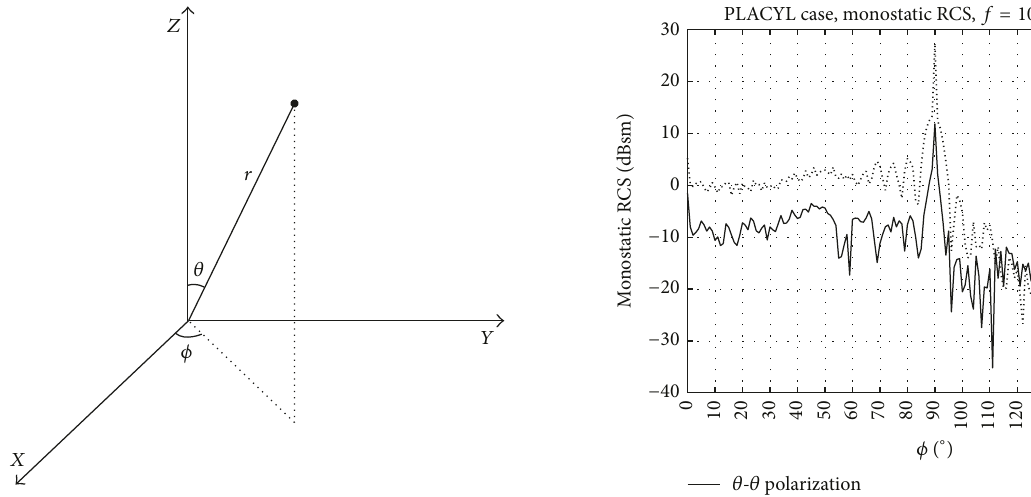
Figure 1: Depiction of the spherical coordinates considered.